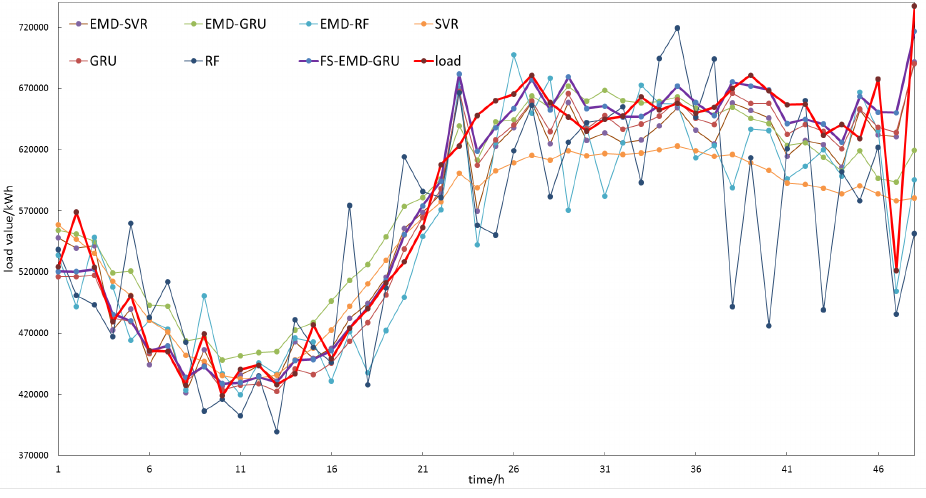
Figure 12. Comparisons of load forecasting results for a certain day in July 2017 in a region of Northwest